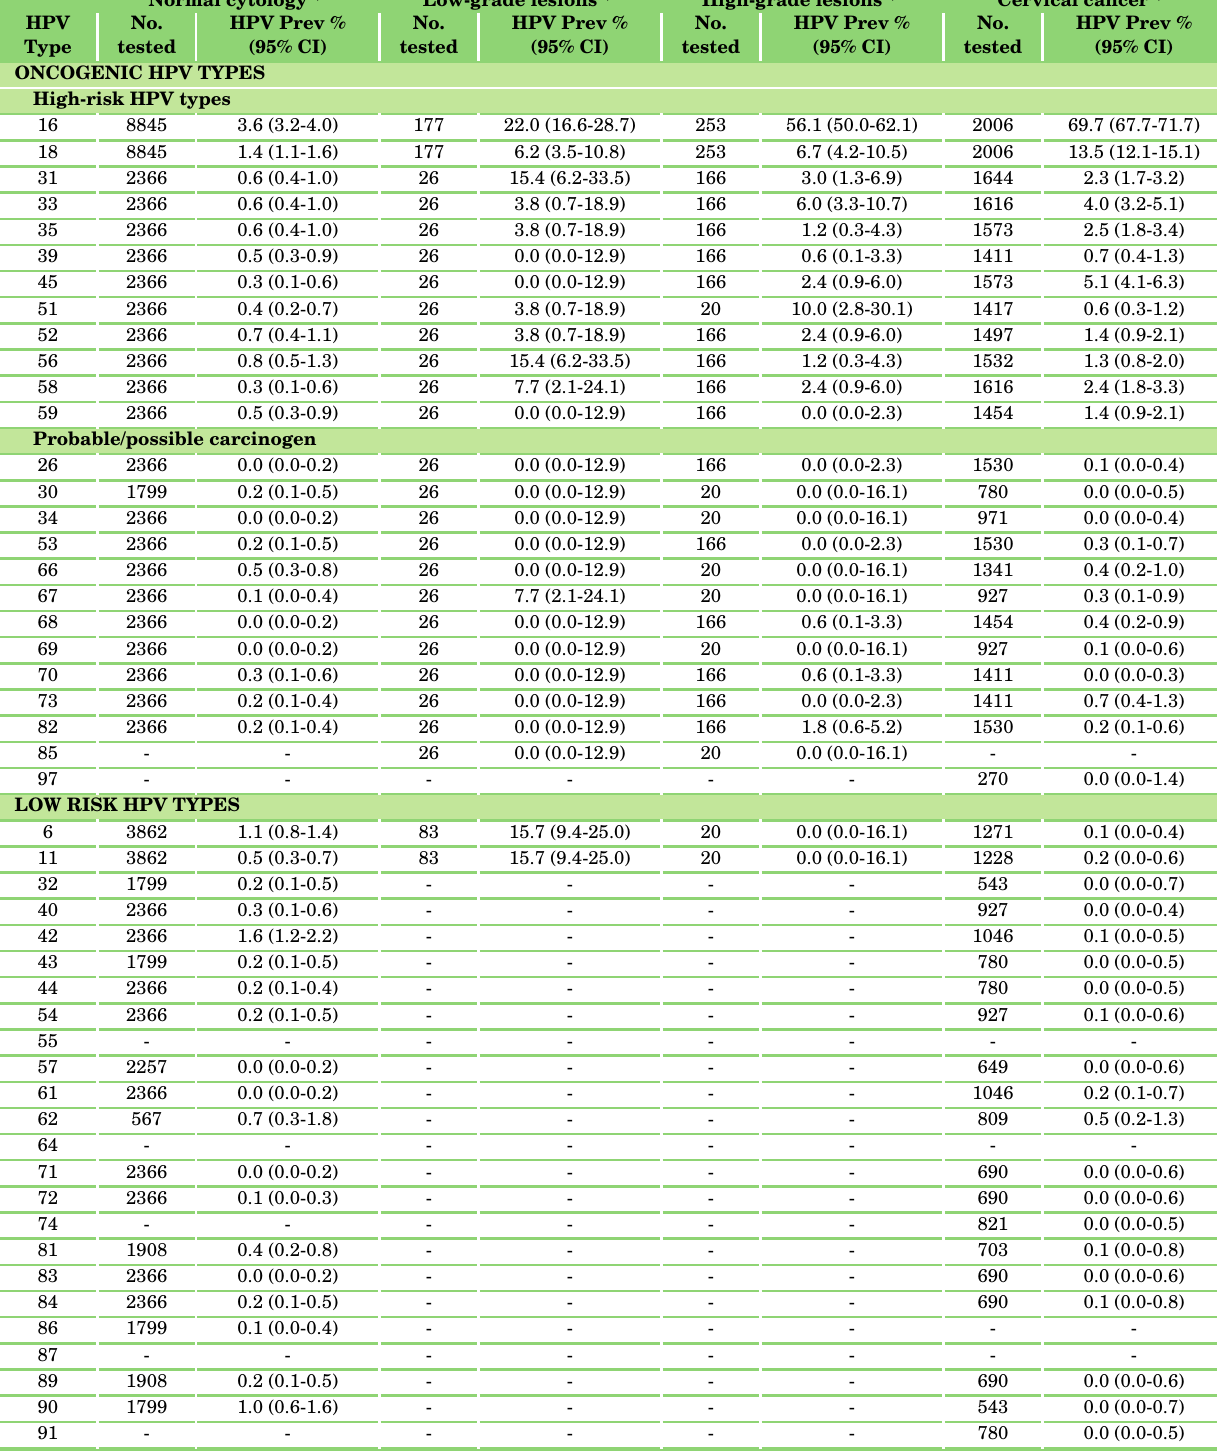
Table 22: Type-specific HPV prevalence in women with normal cervical cytology, precancerous cervical lesions and invasive cervical cancer in India Normal cytology